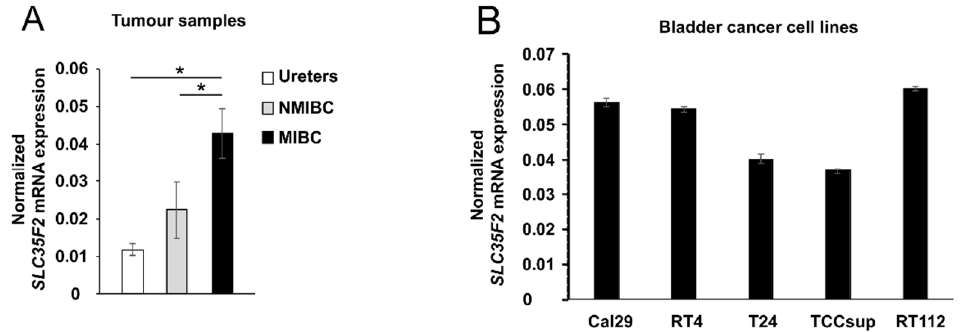
Figure 1. mRNA expression analysis of SLC35F2 in tumour samples and bladder cancer cell lines. ( A ) SLC35F2 mRNA expression of eight matched non-muscle-invasive bladder cancer (NMIBC) and MIBC patients; ( B ) SLC35F2 mRNA expression in bladder cancer cell lines. Expression was normalized to housekeeping genes RPS13 and RPS23. The data are expressed as mean ± standard deviation and statistical analysis was performed by non-parametric Mann–Whitney U-test with * p -value < 0.05.